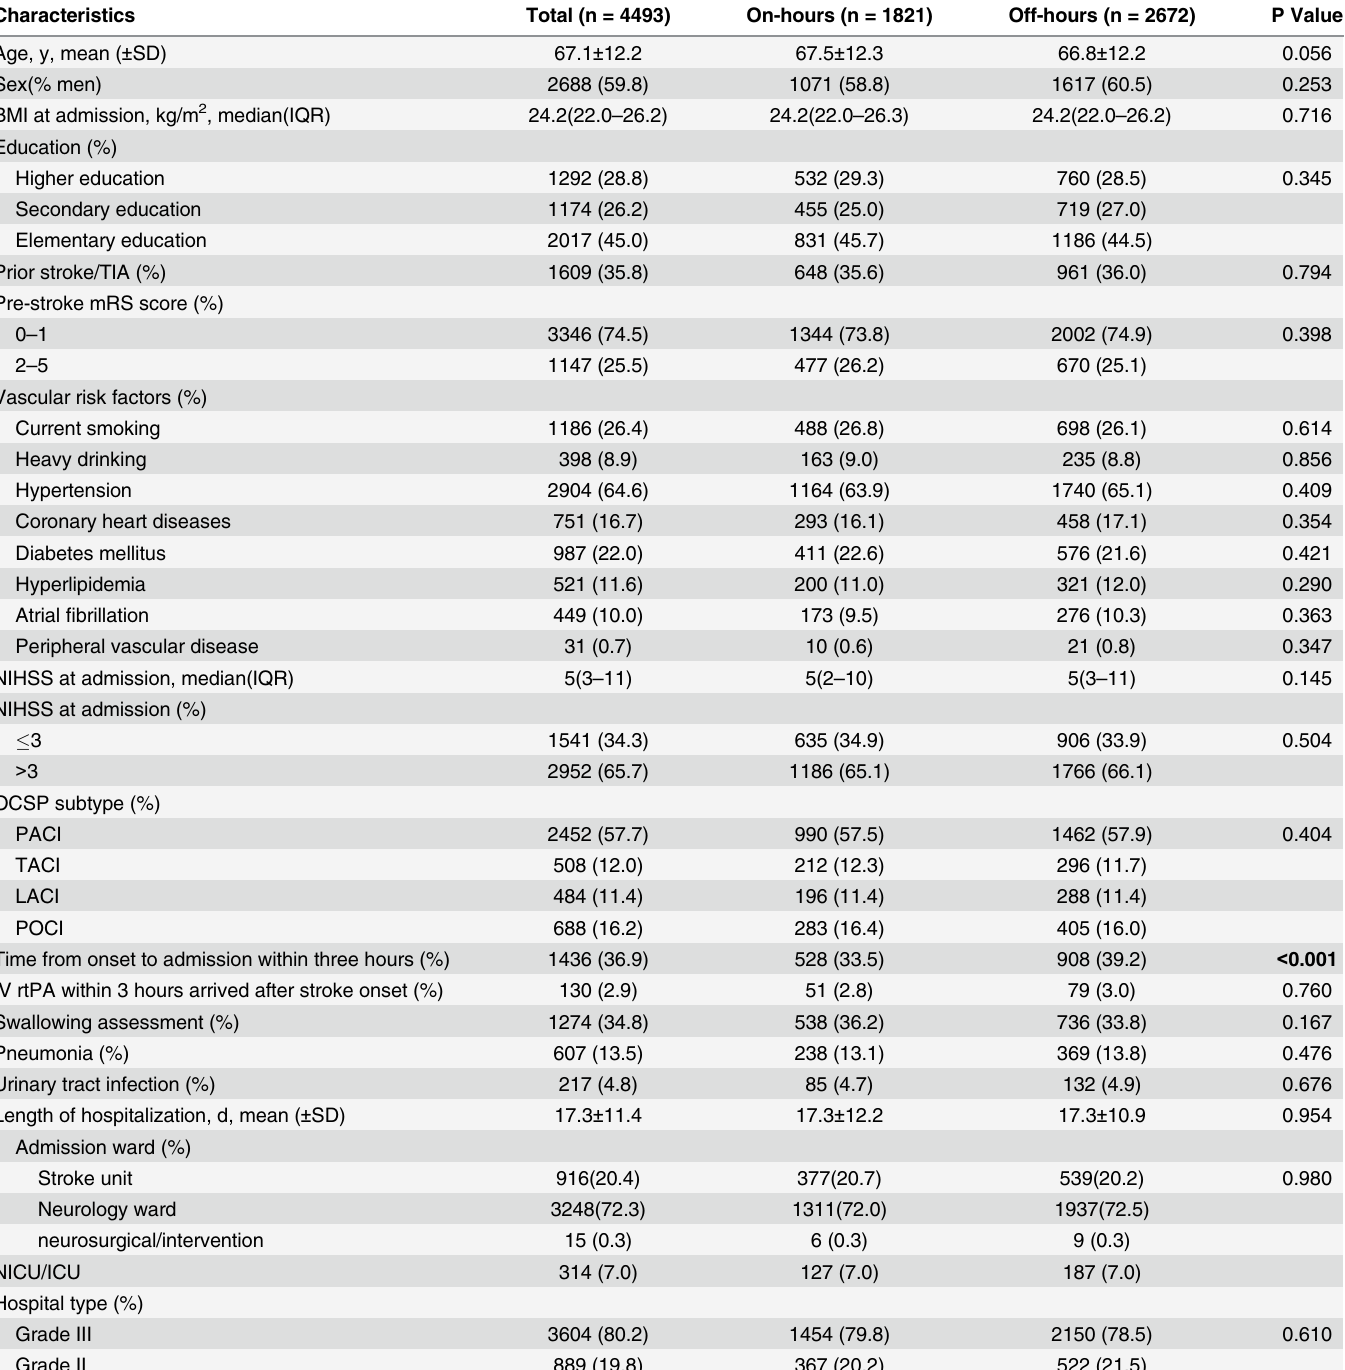
Table 1. Baseline Characteristics of Patients Admitted to the Emergency Departments between On-hour and Off-hour Presentations after Ische- mic Stroke.